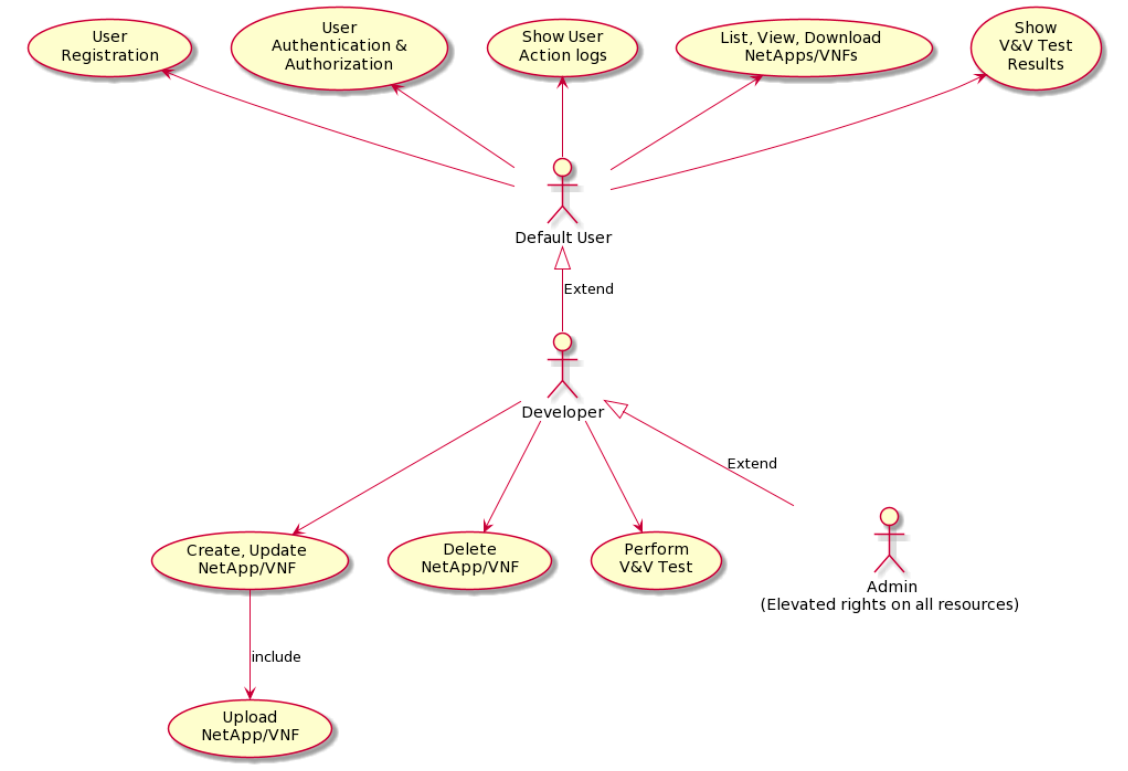
Energies 2021 , 14 , x FOR PEER REVIEW Figure 4. Smart5Grid platform main functionality and actors diagram. Figure 4. Smart5Grid platform main functionality and actors diagram.